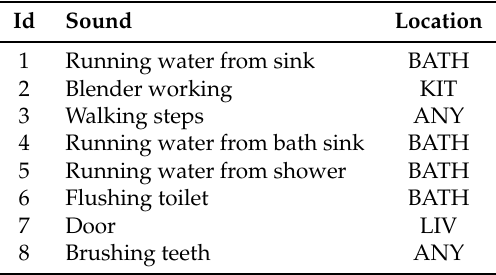
Table 1. Audible home activities annotated and the locations in which they were produced. Living room: LIV; kitchen: KIT; bathroom: BATH; anywhere: ANY.